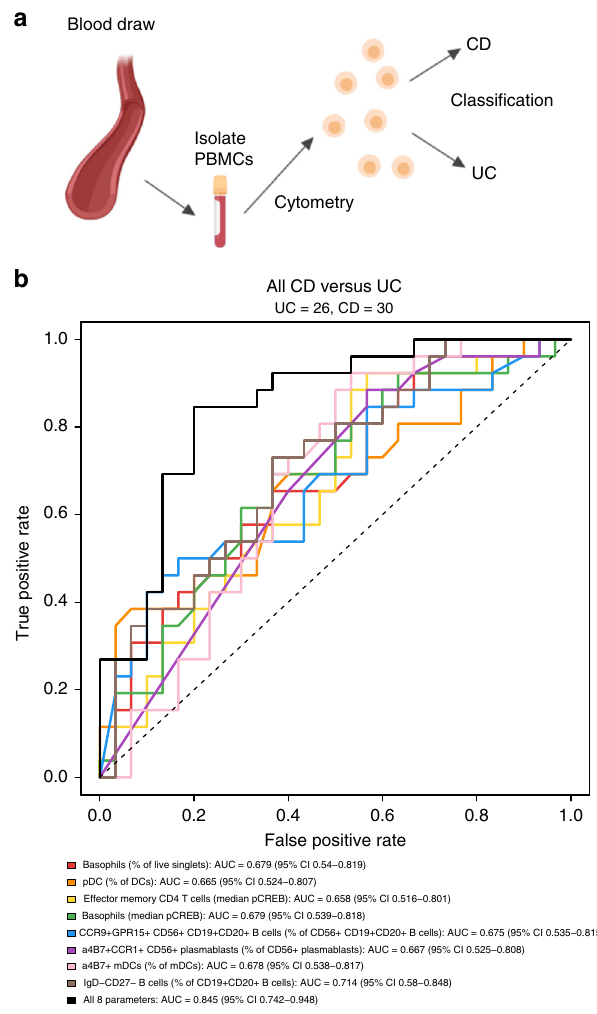
Fig. 7 Signatures in the blood classify IBD patients by clinical subsets. a Schematic of the approach for non-invasive classi fi cation of CD vs. UC based on blood. Blood was drawn from study subjects, peripheral blood mononuclear cells (PBMCs) were isolated and cryopreserved, and samples were analyzed in batches by CyTOF. Created with BioRender. b Generalized linear models (GLMs) were created for eight parameters signi fi cantly different between all CD and UC samples. Corresponding receiver- operating characteristic (ROC) curves are shown for single feature and eight feature models. All CD and UC samples were used to plot ROC curves. UC was used as baseline for the purposes of the GLMs, such that a true-positive indicates correct classi fi cation of a CD sample. Statistics: generalized linear models were constructed using glm in R (see the Methods section). Intercepts and parameter coef fi cients for each model are provided in Supplementary Table 4. Cutoffs and associated